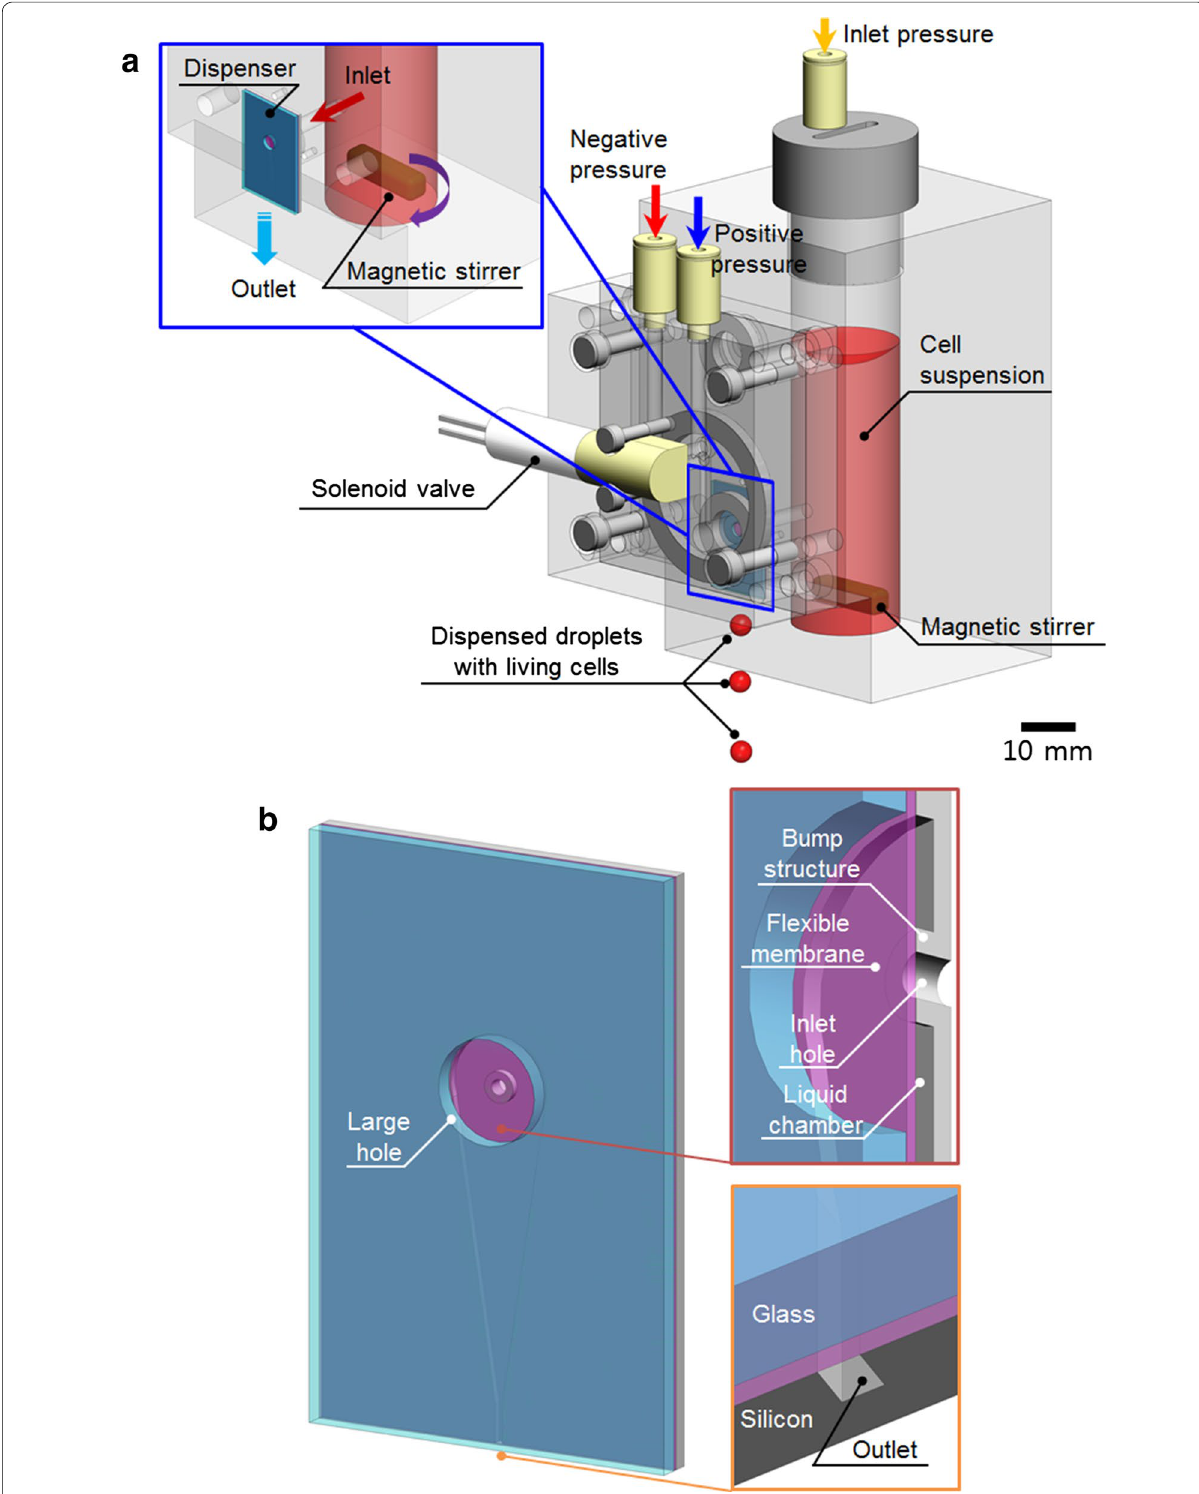
Fig. 1 Schematic views of a cell dispensing system and b dispenser design with a width of 10 mm, a height of 20 mm and a thickness of about 0.8